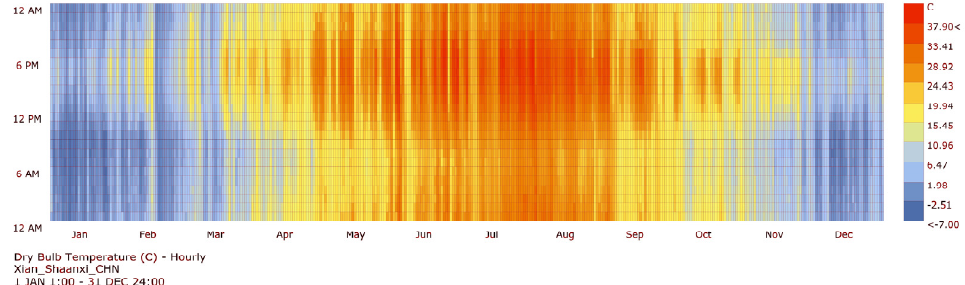
Figure 3. Map of the dry bulb temperatures in Xi’an throughout the year.